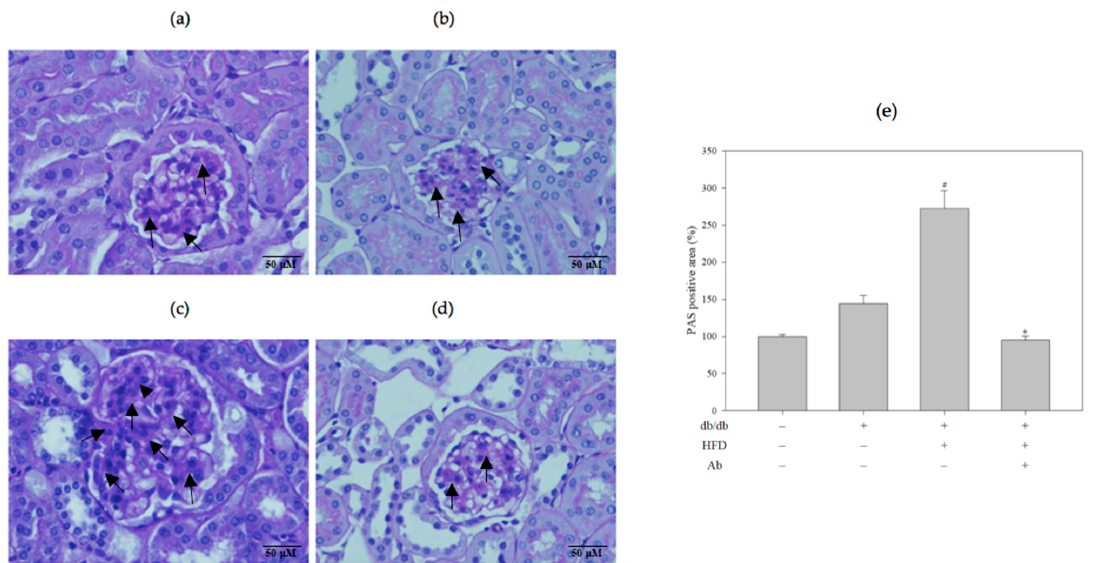
Figure 3. Ab decreased saccharide accumulation in the glomeruli. Kidney slices were embedded in paraffin and stained with PAS reagent. Light photomicrographs of kidney sections from ( a ) control group (C57BL/6 mice), ( b ) db/db group, ( c ) db/db+HFD group, ( d ) db/db+HFD+Ab group were displayed (400 × magnification). The arrow indicates saccharide expression in the glomeruli. ( e ) Quantification of the PAS-positive area. Fifteen microscopic fields of glomeruli per mice were randomly examined. Data are presented as mean ± SD; n = 3 mice per group. The results were analyzed using the analysis of Student’s t -test. #, p < 0.05 compared with control group. *, p < 0.05 compared with the db/db +HFD group.